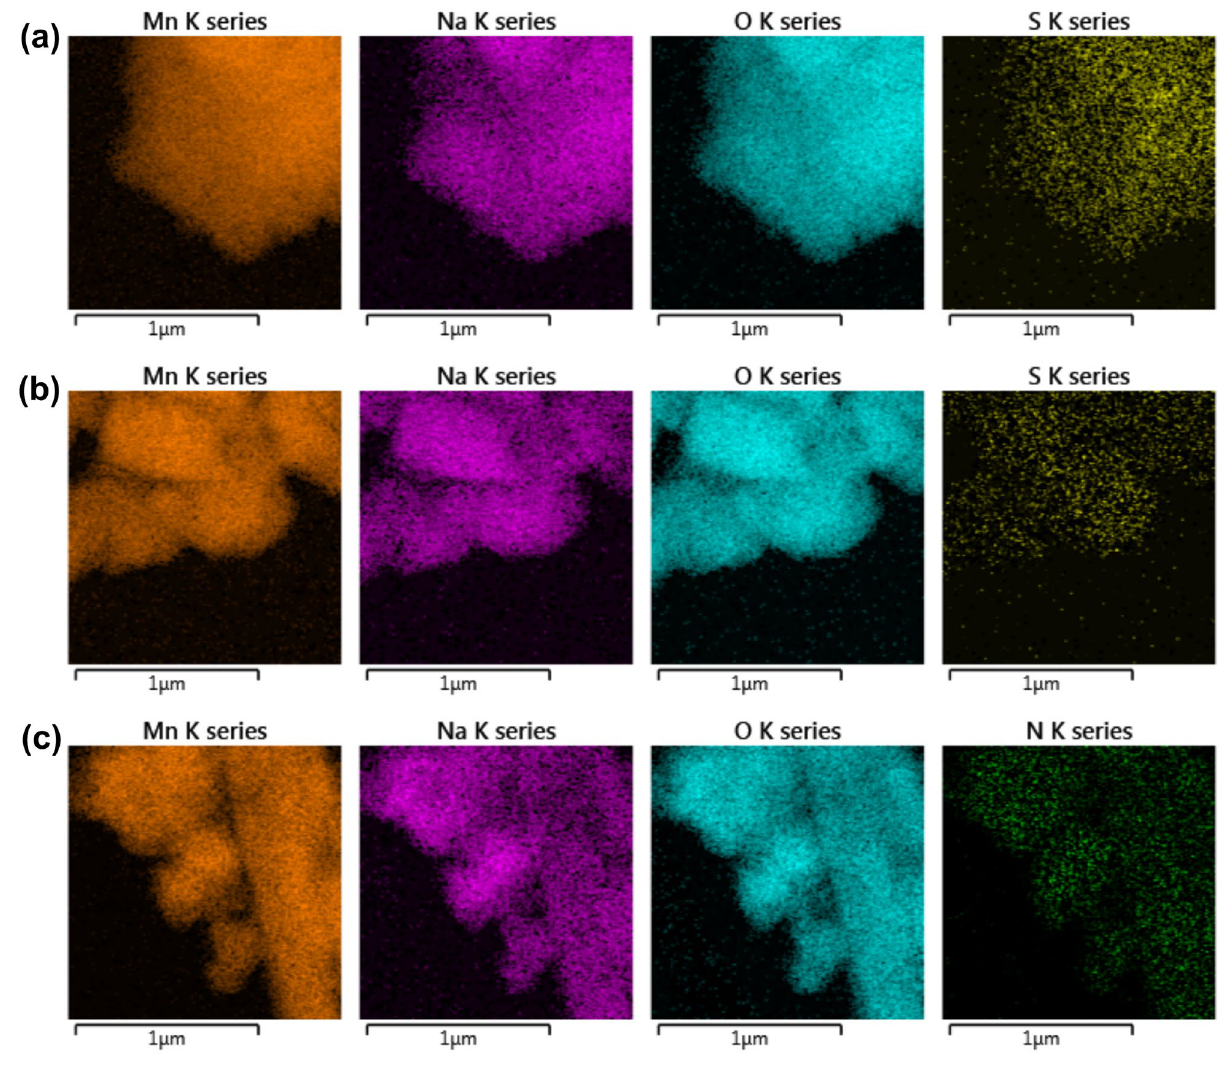
Figure 5. 2D elemental mapping of ( a ) NMO_H 2 S; ( b ) NMO_SO 2 ; ( c ) NMO_NO 2